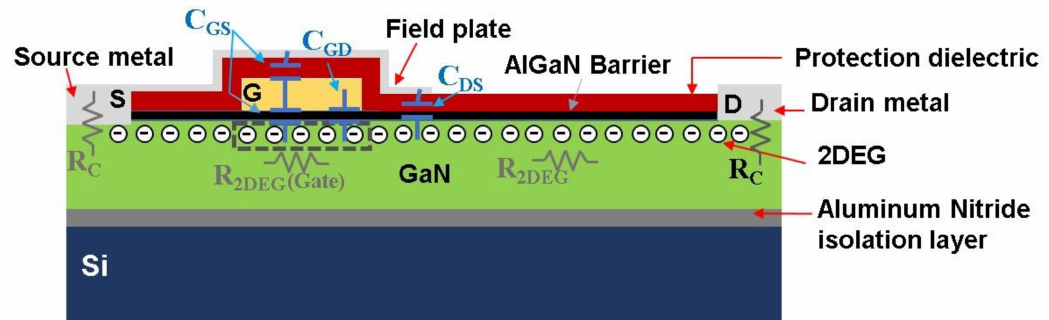
Figure 1. Simplified enhancement-mode GaN FET structure. The physical structure is shown in the on-state operation with the activated channel under the gate (dotted line). The 2DEG area is indicated. The on-resistances and the parasitic capacitors distribution are also highlighted.